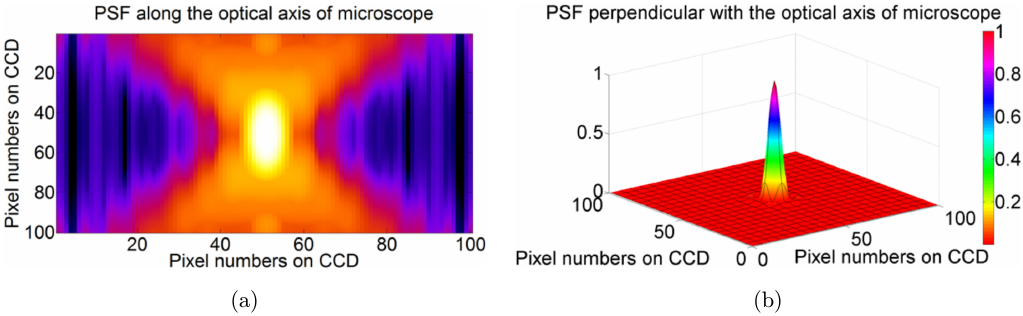
Fig. 1. PSF of a conventional microscope (a) along the optical axis and (b) across the focal plane of